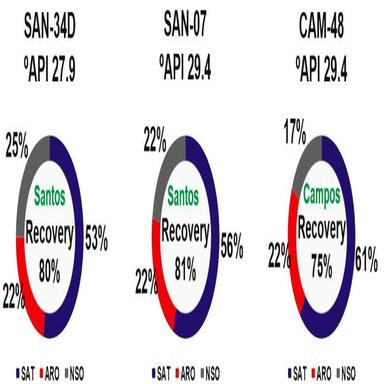
Sample code, ◦API, basin, and compound class distributions, in mass percentage (%) from gravimetric analysis (SAT = saturated hydrocarbons; ARO = aromatics; NSO = polar compounds).